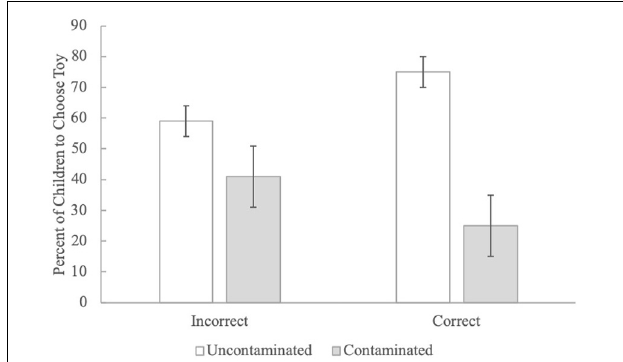
FIGURE 3 | The percent of children who chose the uncontaminated toy in the behavioral post-test across conditions based on whether they answered the open-ended contagion question correctly at